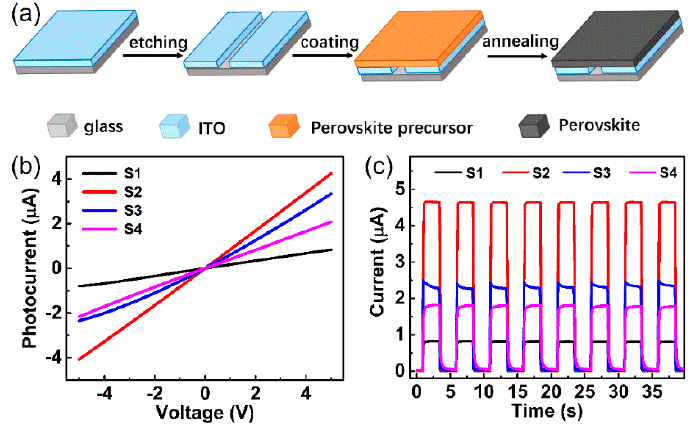
Figure 4. ( a ) Schematic diagram of the stepwise procedures for the fabrication of perovskite-based photodetectors with a device structure of ITO/perovskite/ITO. ( b ) IV measurement taken with a sample bias from − 5 V to +5 V. ( c ) Time-dependent photocurrent curves taken at 5 V sample bias. The devices were fabricated based on perovskite films with various MAI:PbI 2